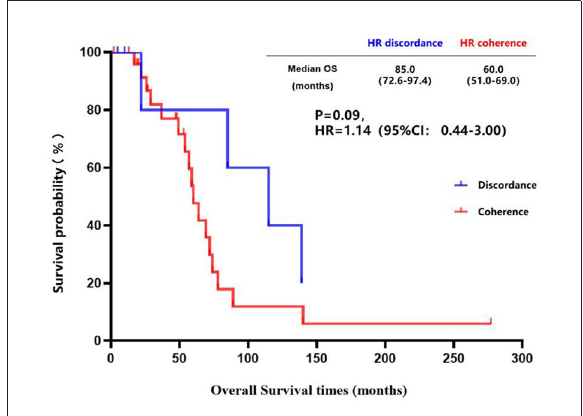
FIGURE5 Kaplan-Meier curves of the overall survival in patients with consistent HR expression vs. patients with inconsistent HR expression.